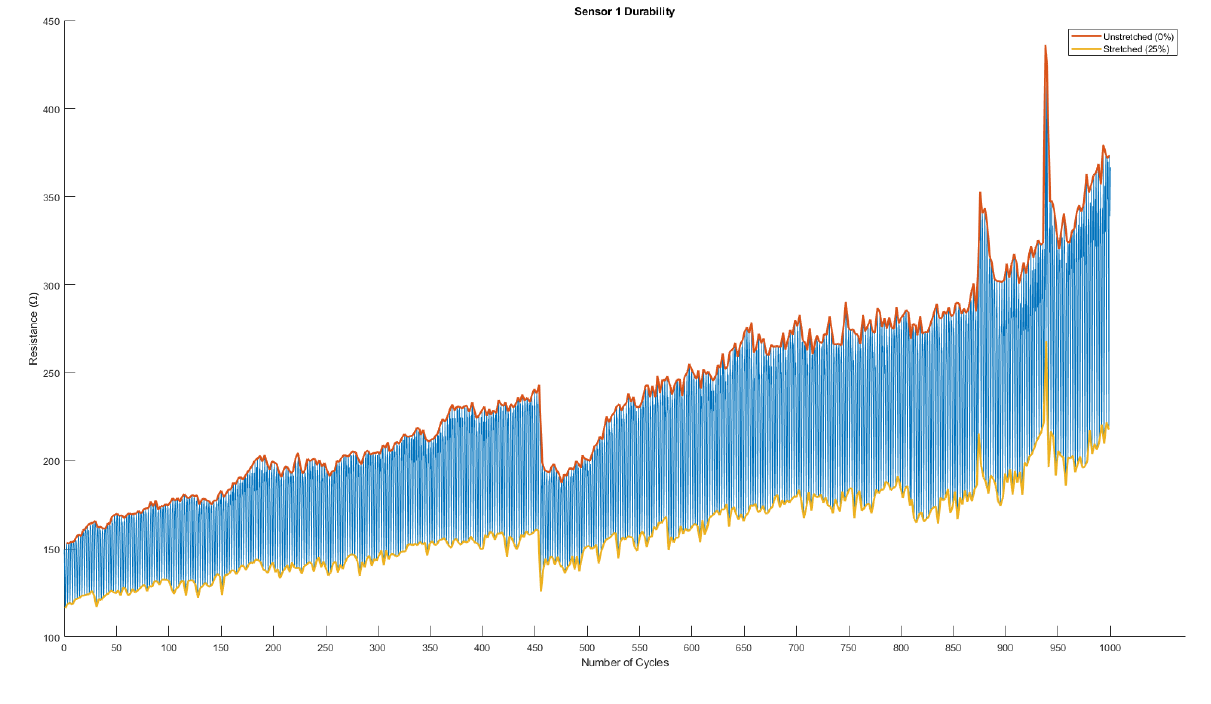
Figure A1. Durability Result (Sensor-1).